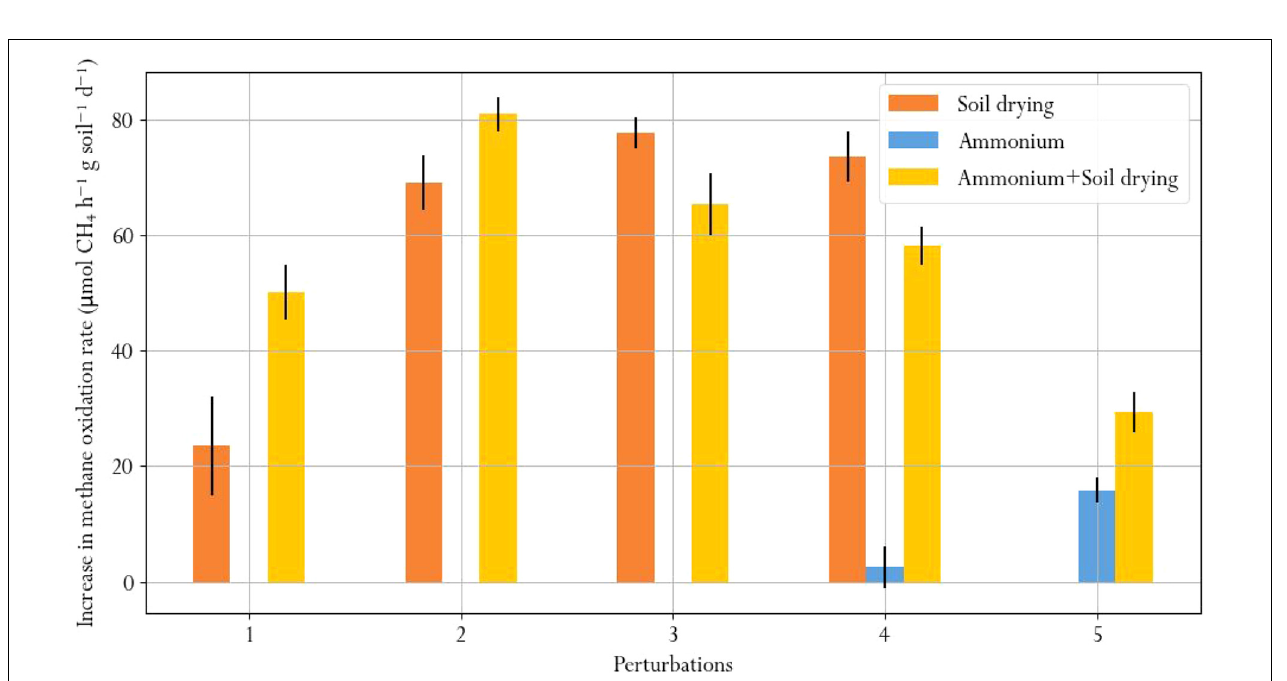
FIGURE 7 | Average daily increase in methane oxidation rate during the first 6 days after each perturbation, indicating recovery.